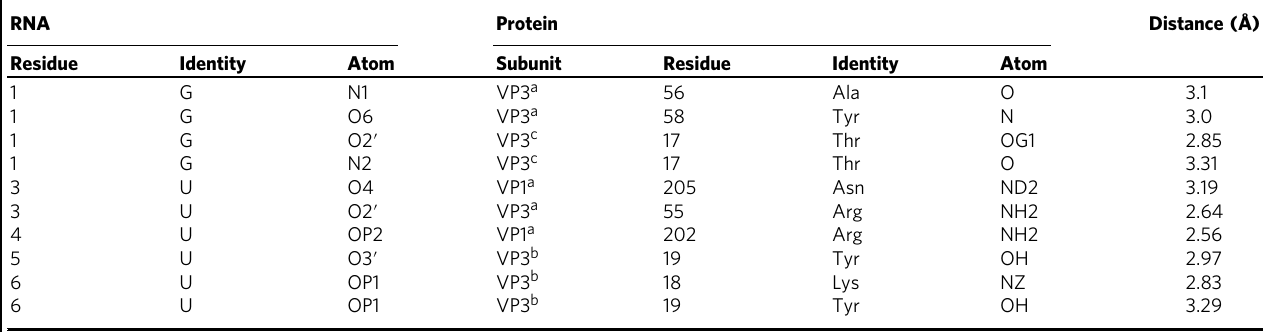
Table 1 Potential hydrogen bonds between RNA and capsid RNA